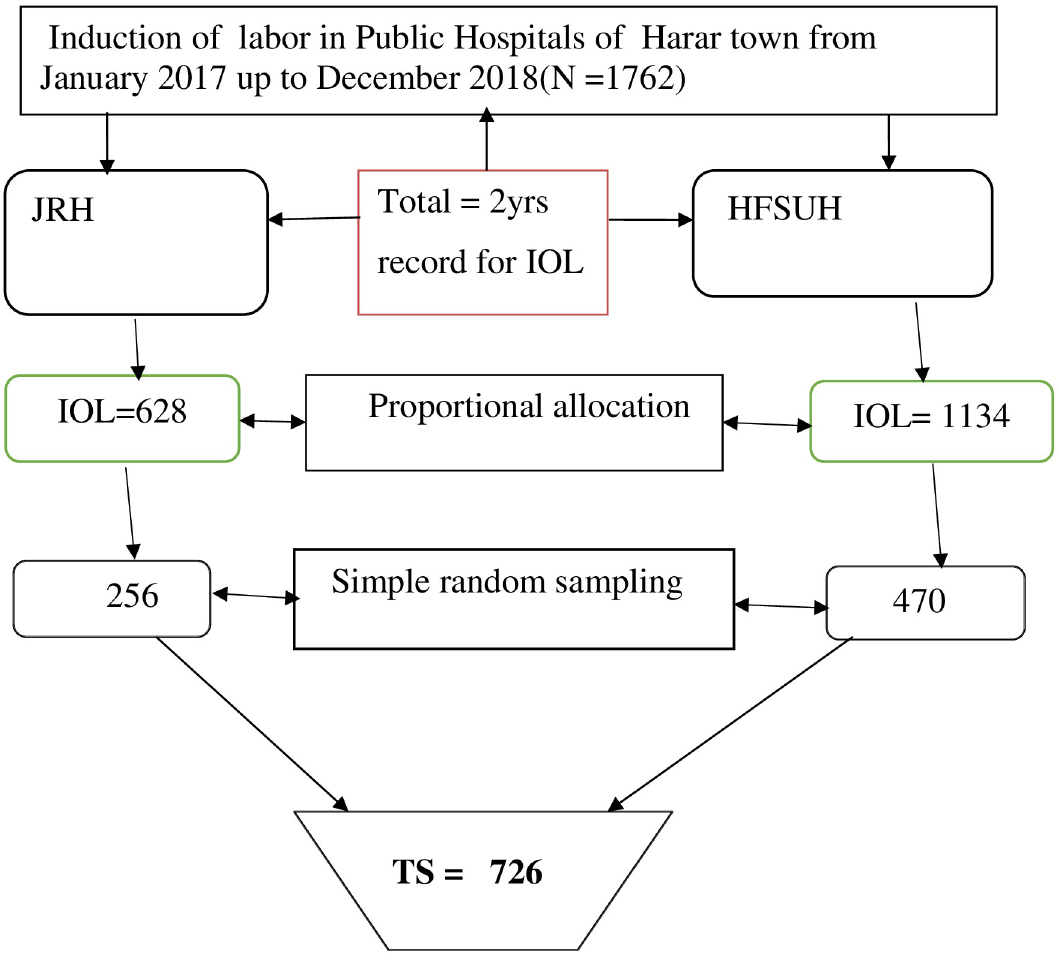
Fig 1. Schematic presentation of sampling procedure among mothers who delivered after induction of labor in public Hospitals of Harari Regional State, Eastern Ethiopia, 2019.